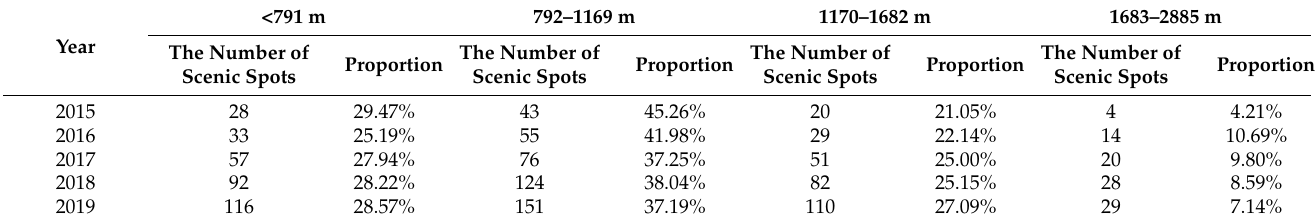
Table 4. Distribution of A-level scenic spots at different elevations.